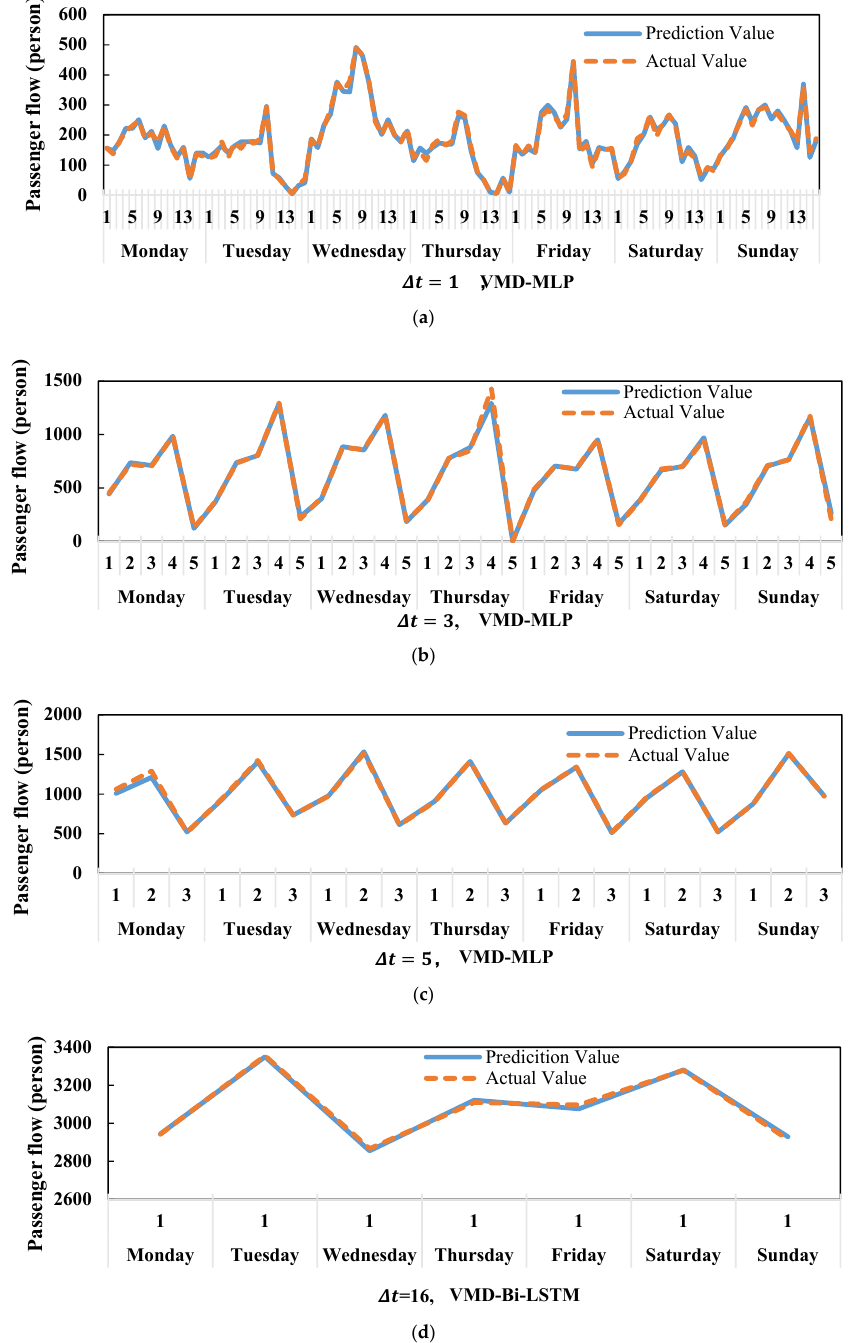
Figure 7. Comparison between the prediction value and the actual value under different time granularities. ( a ) Prediction results of model VMD-MLP under time granularity ∆ t = 1, ( b ) Prediction results of model VMD-MLP under time granularity ∆ t = 3, ( c ) Prediction results of model VMD-MLP under time granularity ∆ t = 5, ( d ) Prediction results of model VMD-Bi-LSTM under time granularity ∆ t =